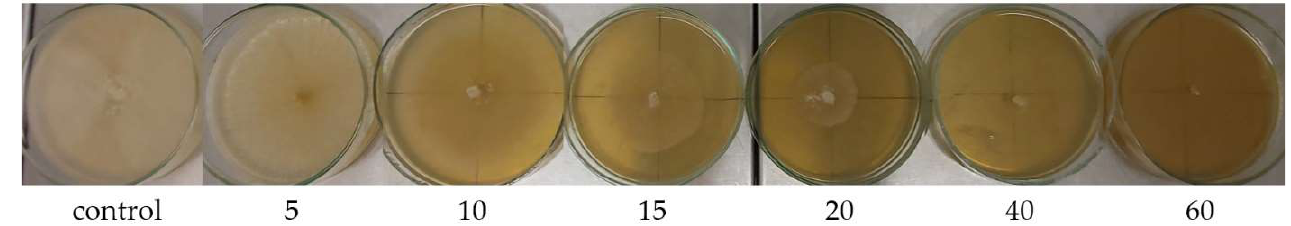
Figure 3. Growth of Ch. globosum on a malt-agar medium containing various amounts (mL/100 mL) of mint extracts M. × piperita ‘Almira’.